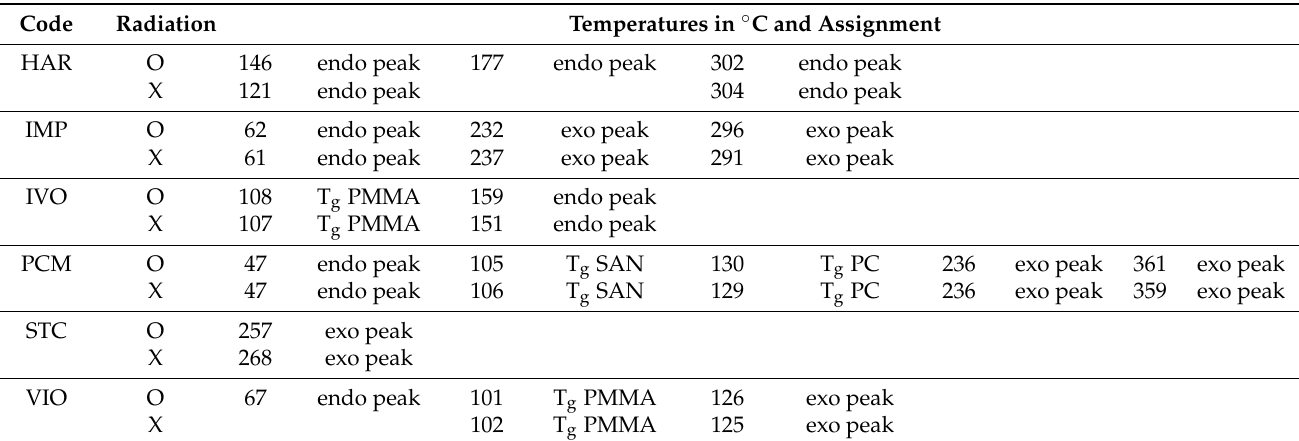
Table A1. Identified temperatures for irreversible peaks and glass transitions (midpoint) in DSC curves of investigated materials exposed to X-ray irradiation during µ XCT measurements (X) and unexposed (O) specimens. Code Radiation Temperatures in ◦ C and Assignment